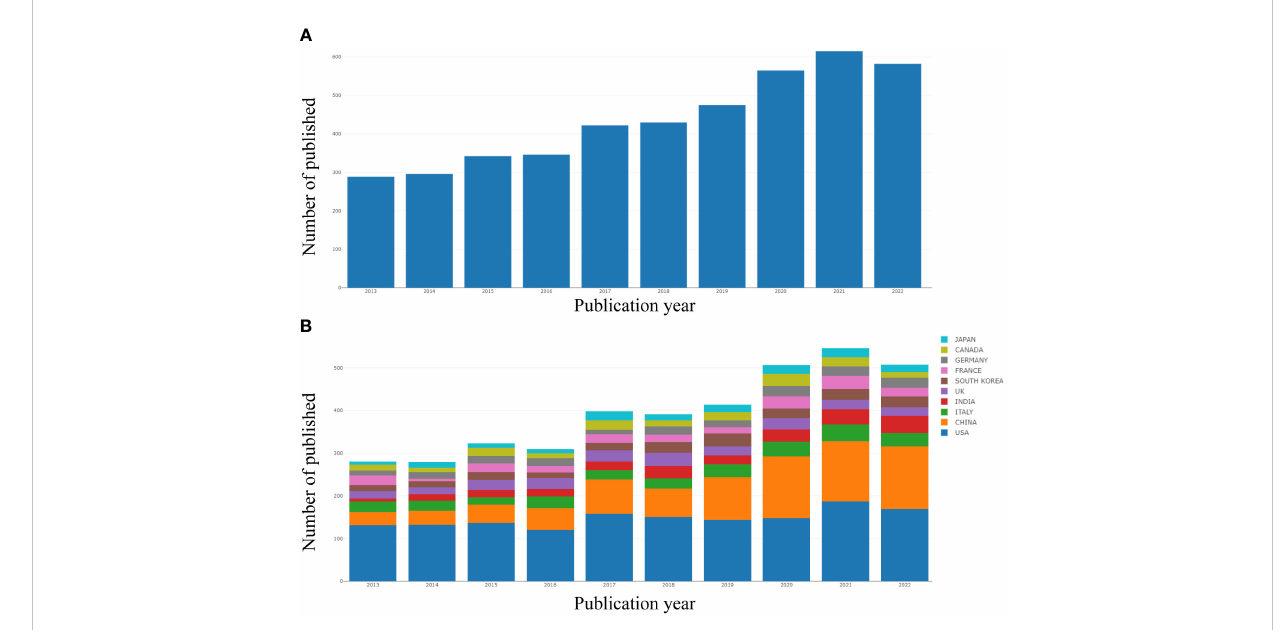
FIGURE 2 Data on annual publication counts (A) and growth rates among the top 10 nations (B)